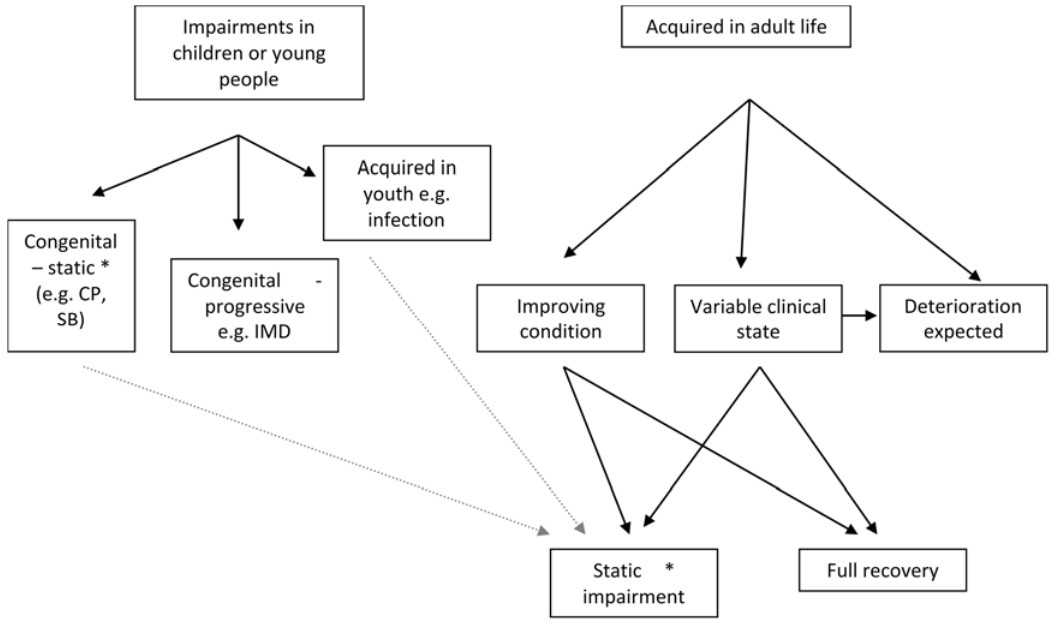
Figure 1. Potential clients for VR (vocational rehabilitation) services. CP, cerebral palsy; SB, Spina Bifida; IMD, Inherited metabolic disorders; *, May deteriorate slowly over time.